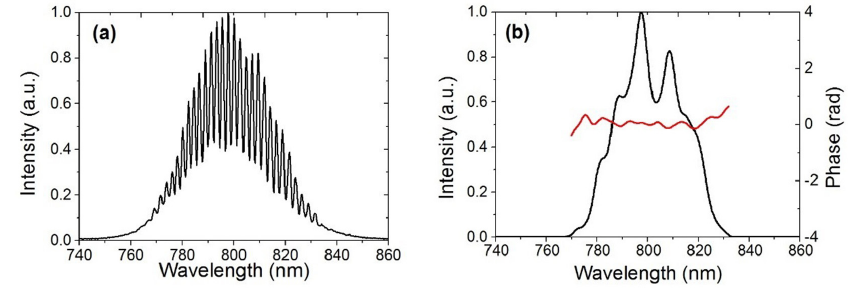
Figure 6. Typical results obtained by Wizzler. ( a ) Spectrum interferogram. ( b ) Reconstructed spectrum (black line) and spectral phase (red line).